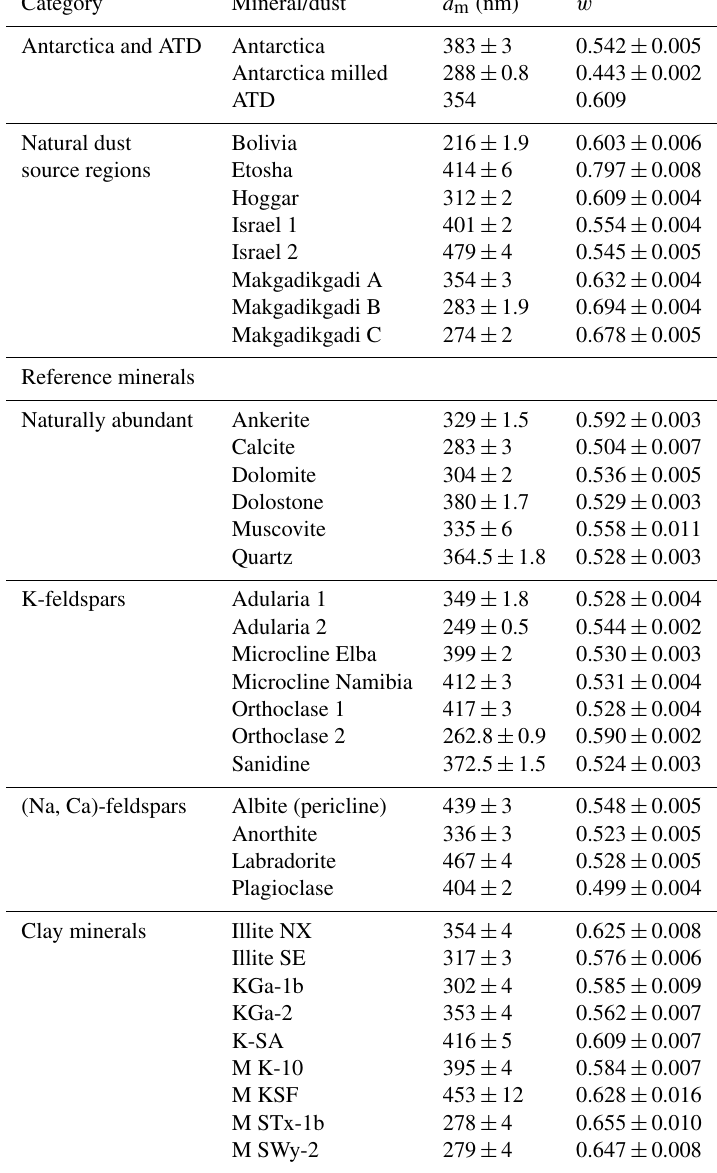
Table 1. Lognormal size distribution parameters d m (nm) and w for the analysed samples according to Eq. (1). Error ranges reflect fit uncertainties. For the Oman and Qatar samples not enough material was available to measure the size